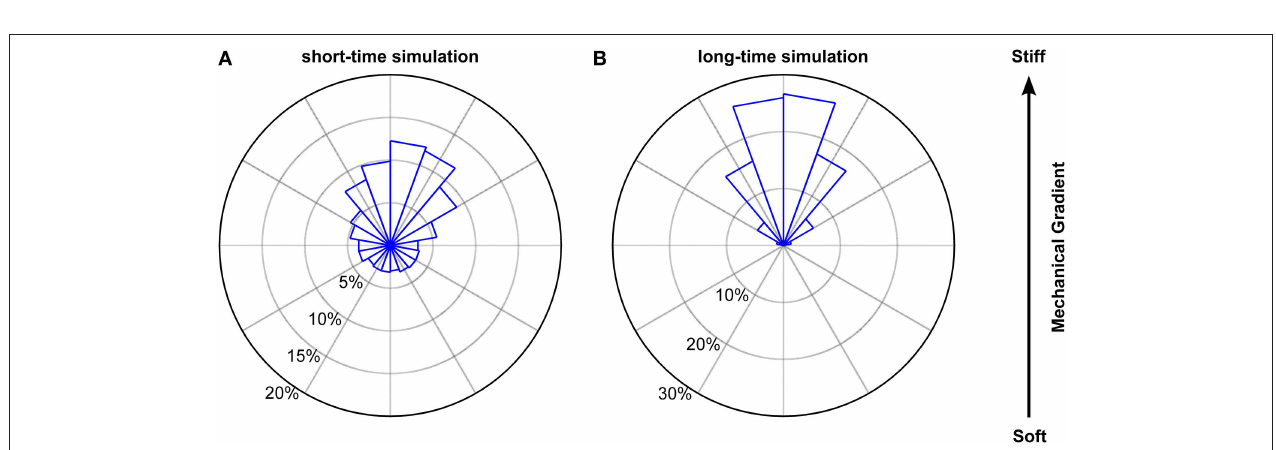
FIGURE 9 | Step lengths are distributed according to a Burr distribution. Step-length distributions for the forward (A) , sideways (B) and backward movements (C) of microglia relative to their previous step direction. Red curves represent the best Burr distribution fits. (D) Step-length distributions were normalized by their standard deviation. Blue curves show the normalized stress distributions for the forward, sideways, and backward movements, which were statistically similar ( p > 0 . 20 , Kruskal-Wallis ANOVA). The red curve shows the Burr distribution fit for all data combined.